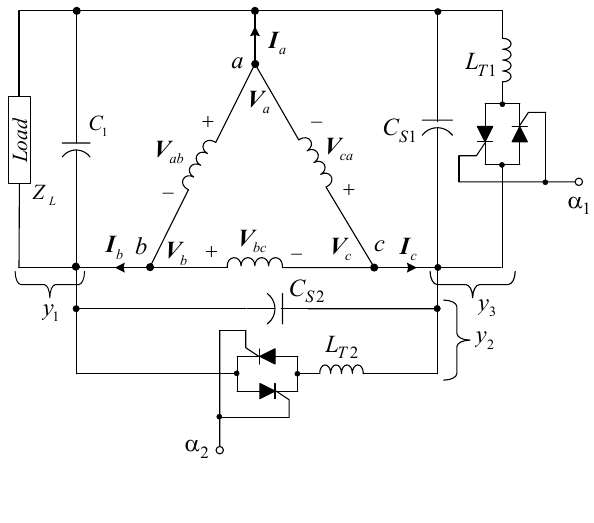
and C using two 2 3